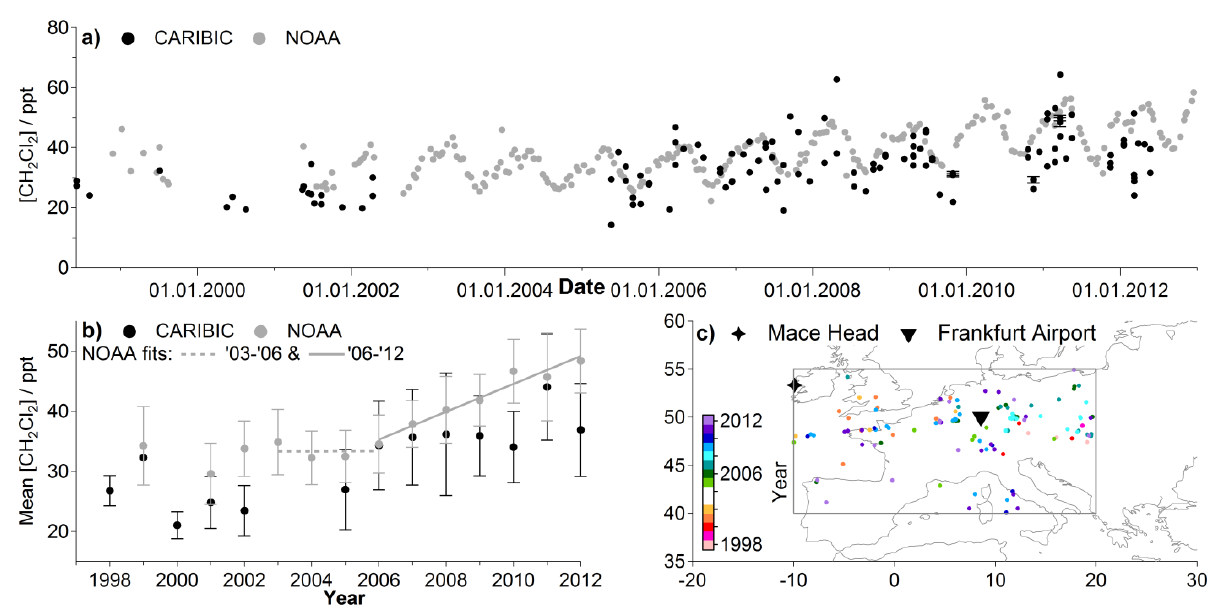
Figure 2. (a) European CH 2 Cl 2 time series from June 1998 to December 2012. Where a sample was analysed multiple times an error bar is given based on the variation between these measurements, see Sect. 2. (b) The mean value of all CH 2 Cl 2 values taken within this region for each year (“annual tropospheric value”), shown separately for CARIBIC and NOAA Mace Head data, error bars are 1 σ . (c) Geographical distribution of CARIBIC samples within the European region 40–55 ◦ N and − 10–20 ◦ E. Frankfurt Airport (CARIBIC2 base) and the NOAA sampling site at Mace Head are also shown. Samples are coloured by